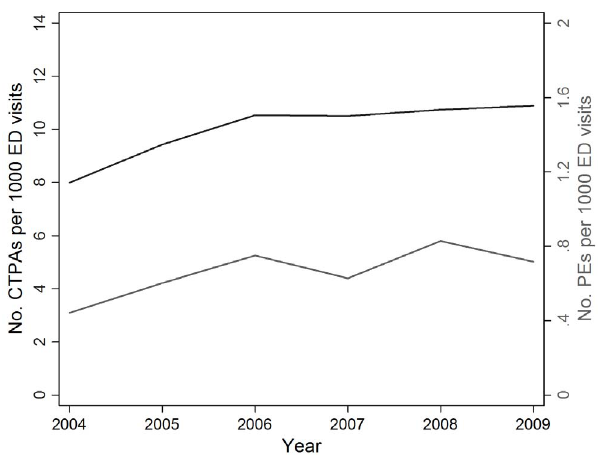
Figure 1. Annual CTPA utilization patterns. Graph shows an increase in the number of CTPAs ordered from 2004 to 2009